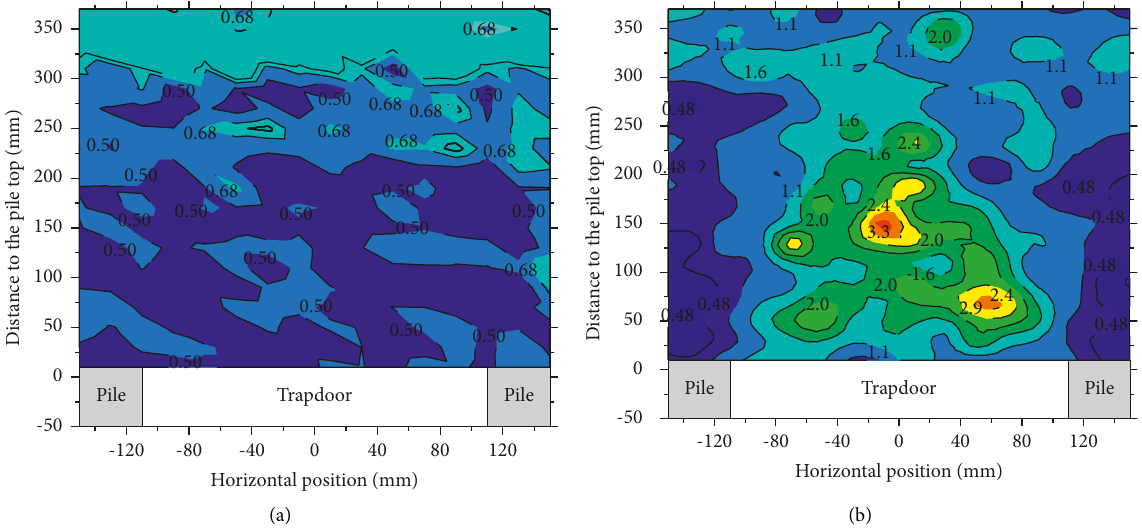
Figure 11: Coefficient of lateral earth pressure: (a) before trapdoor displacement and (b) after trapdoor